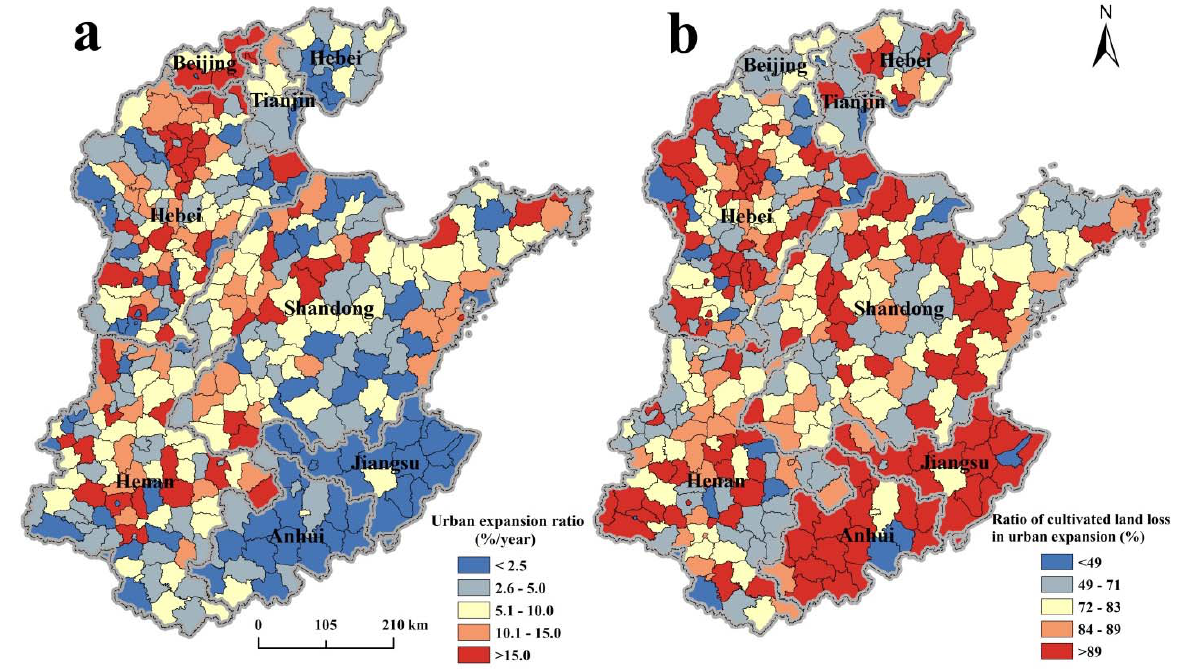
Figure 4. ( a ) Urban expansion rate and ( b ) cultivated land loss ratio in urban expansion in the NCP during the period